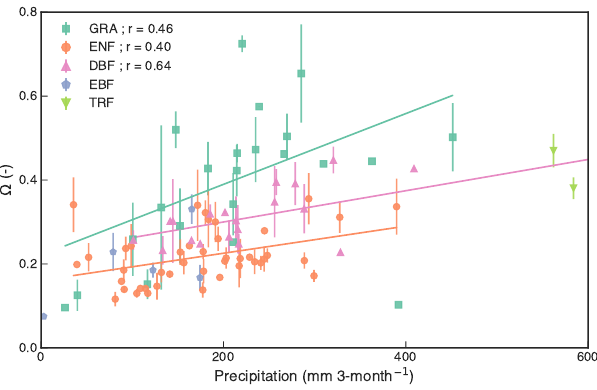
Figure 3. Values of the estimated coupling coefficient ( (cid:127) ) for for- est (ENF, EBF, DBF, TRF) vegetation and grasses as a function of precipitation in the three most productive months. Only data for 90% of the three most productive months were flagged as “good” and are shown. Lines indicate statistically significant regressions ( P < 0 . 05). Plant functional types are defined as GRA – grasses, ENF – evergreen needleleaf forest, EBF – evergreen broadleaved forest, DBF – deciduous broadleaved forest, and TRF – tropical rain forest.